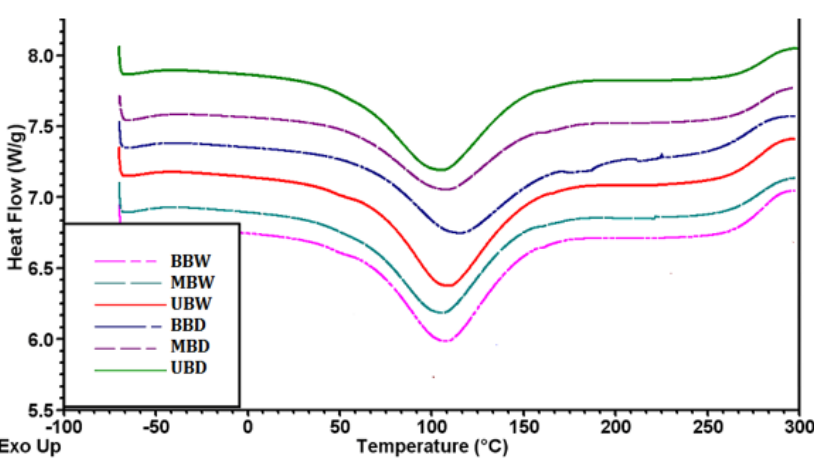
Figure 12. Differential scanning calorimetry (DSC) thermograms of okra fibers. Figure 12. Di ff erential scanning calorimetry (DSC) thermograms of okra fibers.